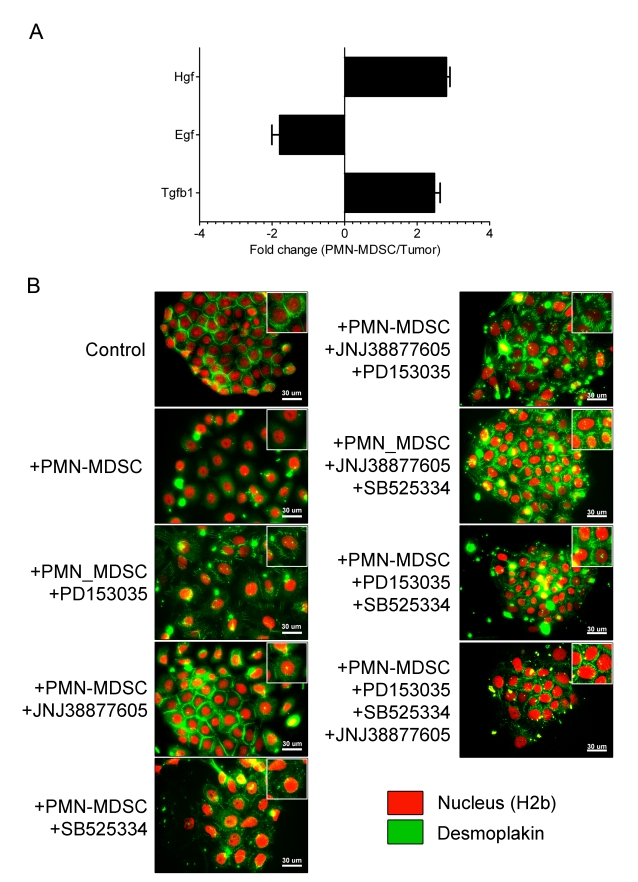
Inducers of EMT.(A) Expression of Hgf, Egf, and Tgfb1 genes in RETAAD tumors analyzed by qRT-PCR. Hgf and Tgfb1 are preferentially expressed in PMN-MDSC, while Egf is preferentially expressed in tumor cells. Data are from four individual experiments using sorted fractions of PMN-MDSC and melanoma cells. Bars represent mean ± SD. (B) NBT-II cells (100 cells per well) were plated for 4 d to allow for colony growth and were pre-treated for 24 h with inhibitors before the addition of PMN-MDSC. After co-culture with PMN-MDSCs in the presence of inhibitors, cells were fixed and stained with anti-rat desmoplakin. Green, Desmoplakin; red, H2b (nuclear stain). PD153035 – EGFR inhibitor, JNJ38877605 – c-met (HGFR) inhibitor, and SB525334 – TGF-βR1 inhibitor. Images are representative of three independent experiments.